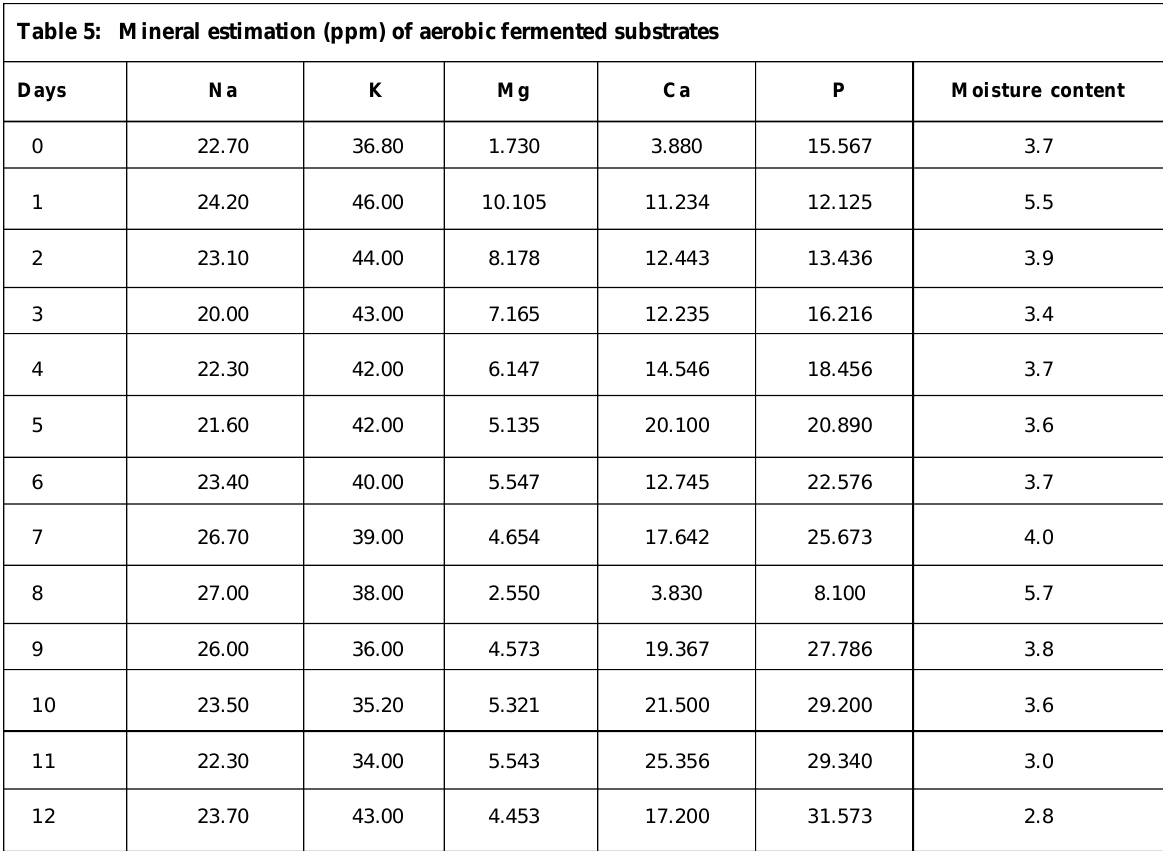
Table 5: Mineral estimation (ppm) of aerobic fermented